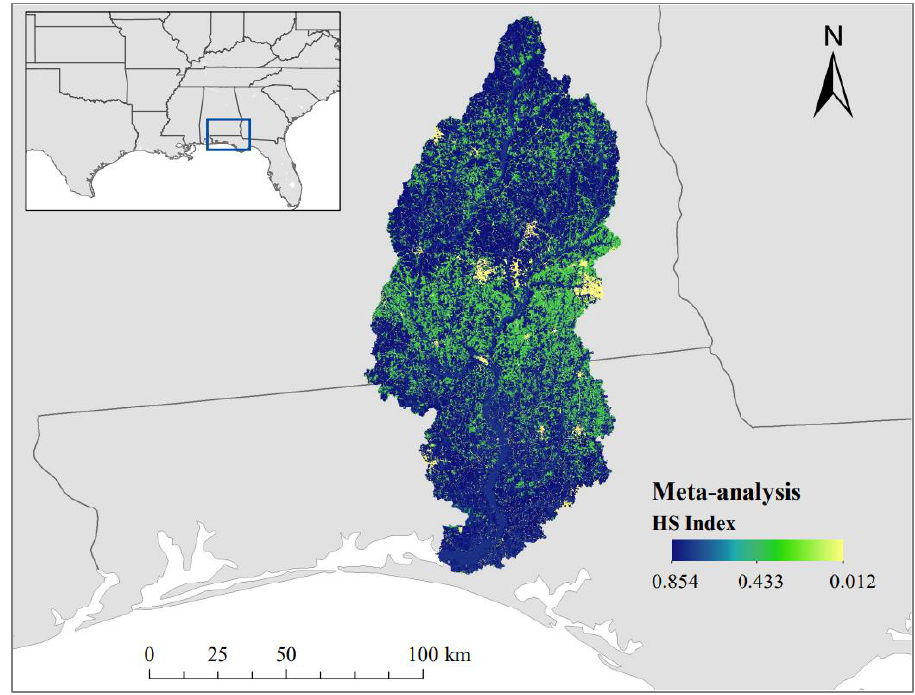
Figure 4. The habitat suitability map of the Choctawhatchee Watershed created using the results of the literature review.